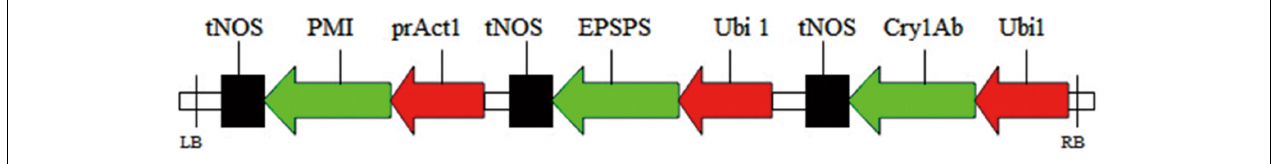
FIGURE 1 | Schematic of the T-DNA vector used for sugarcane transformation. PMI gene promoted by the prAct-1 promoter and the Cry1Ab gene and the EPSPS gene were promoted by the prUbi-1promoter. prUbi-1, maize Ubi-1 promoter; prAct-1, rice Act-1promoter; tNOS, nopaline synthase terminator.